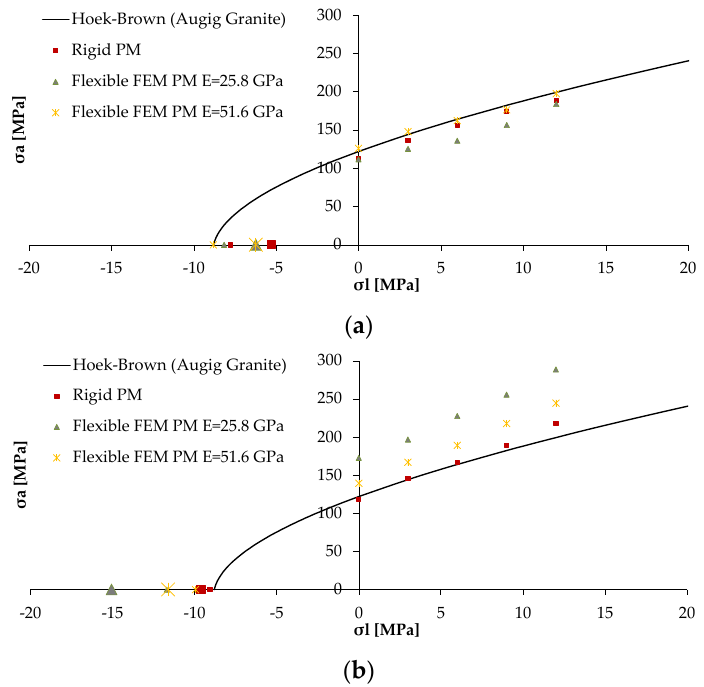
Figure 11. Strength envelope: Hoek–Brown failure criterion adopted from [11], Rigid model [14] and proposed flexible FEM based particle model: ( a ) brittle contact constitutive law; ( b ) bilinear softening contact constitutive